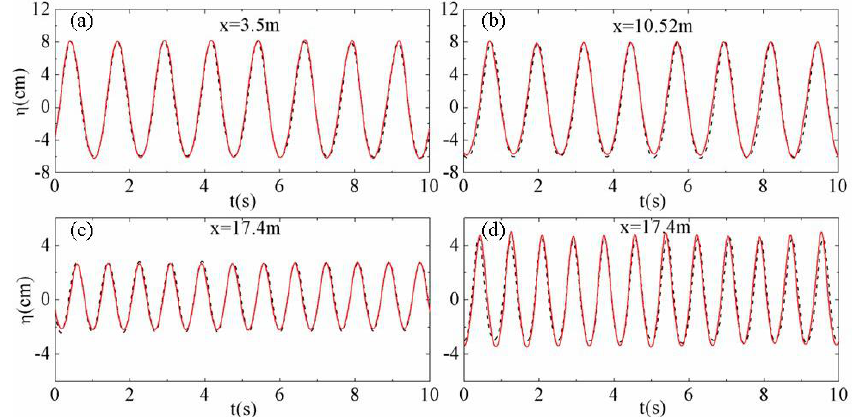
Figure 9. Comparisons of wave elevations between numerical and experimental results for Case A2 (panels ( a , b )), Case B2 (panel ( c )), and Case B4 (panel ( d )). The red solid lines represent wave elevations simulated by the numerical method and the black dashed lines represent wave elevations measured in experiments.